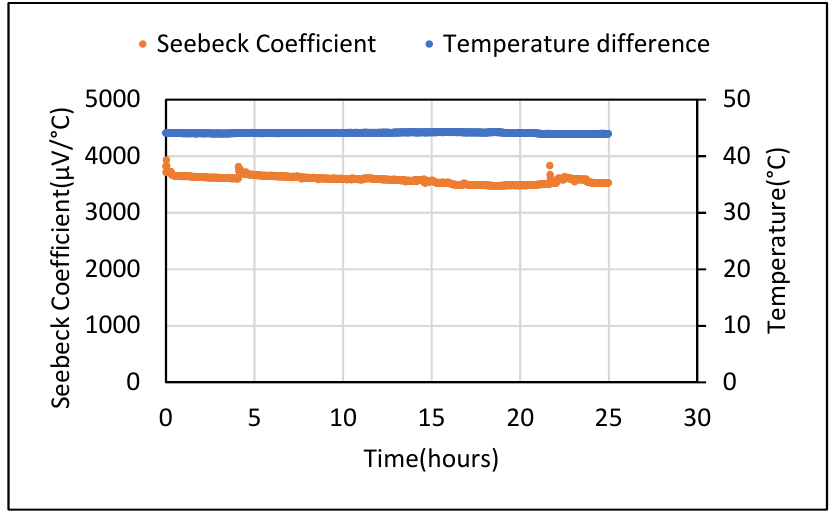
Figure 12. Seebeck coefficient at fixed temperature difference over 1-day time period for 5% Fe 2 O 3 cement composite.